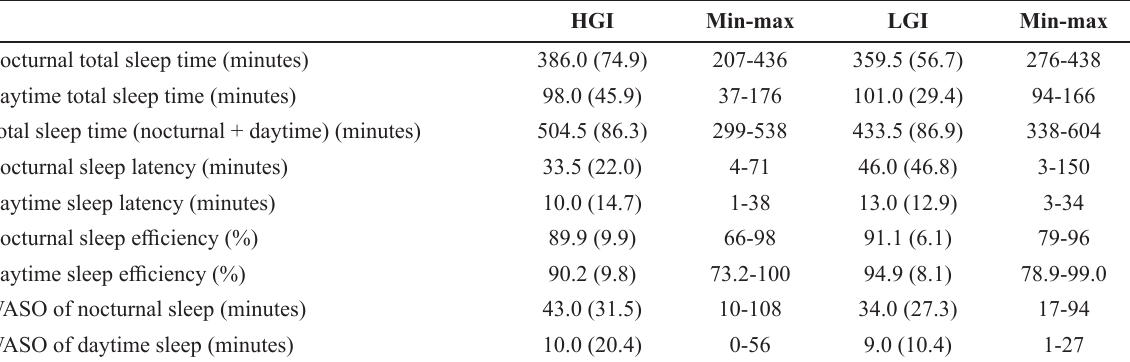
Sleep parameters according to dietary GI